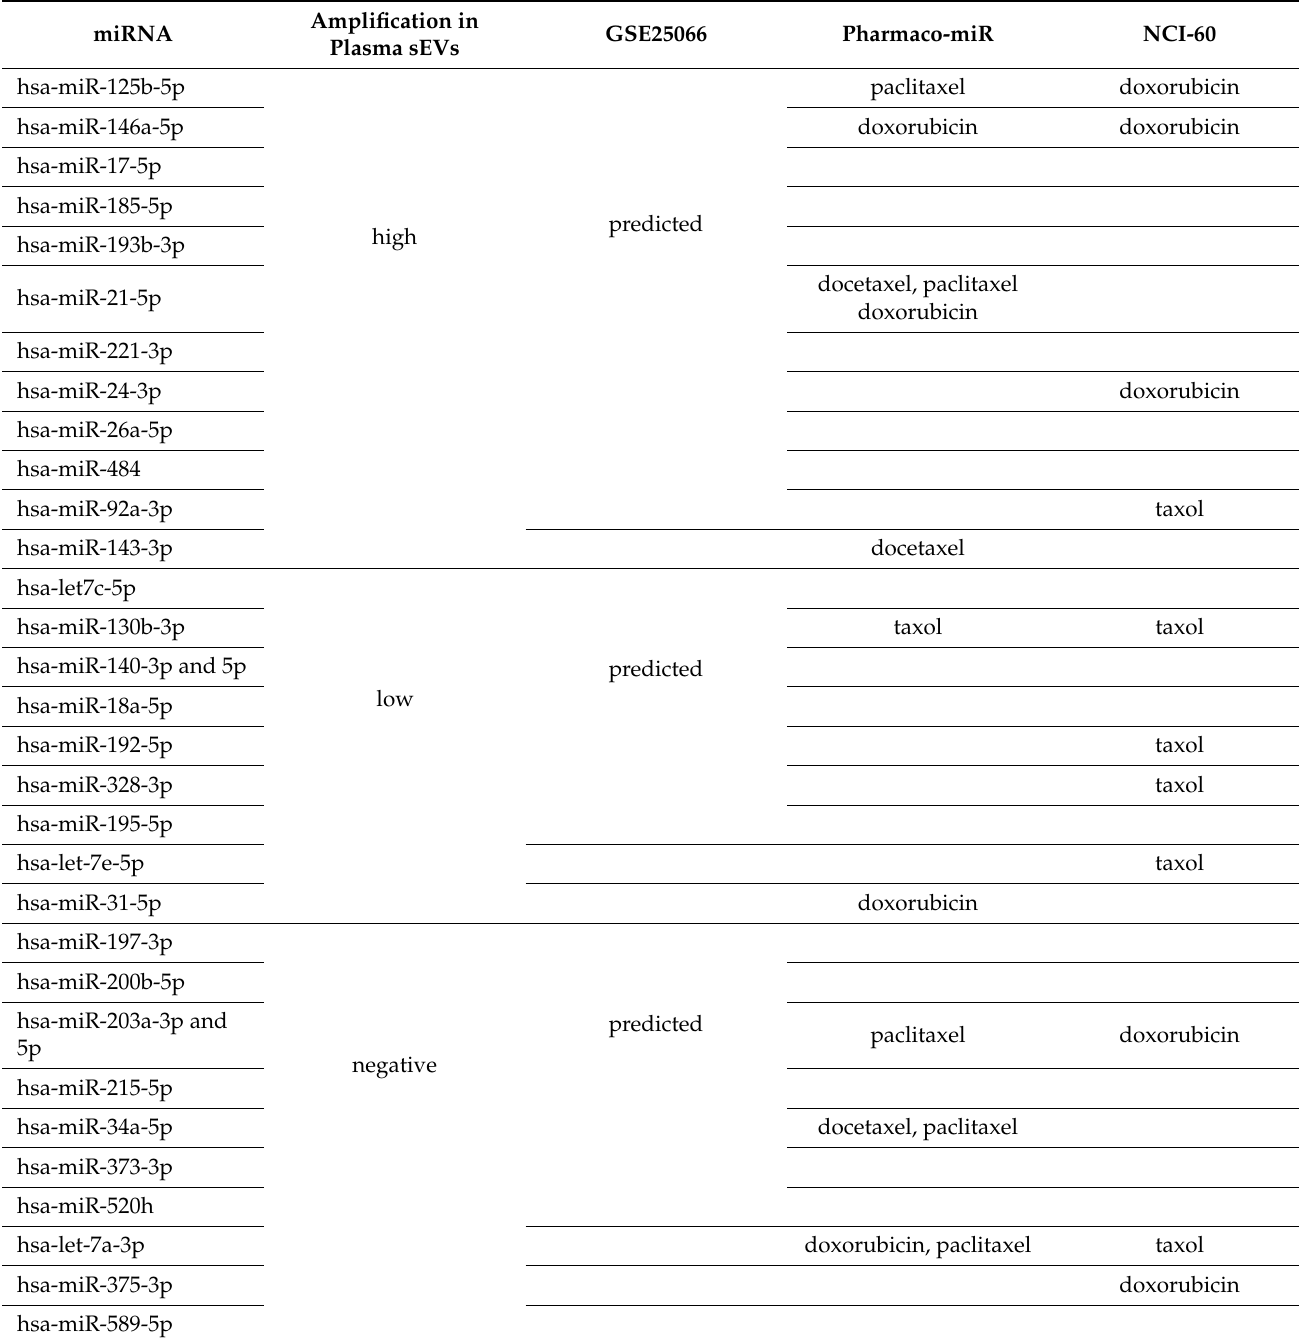
Table 2. Candidate biomarker miRNAs selection and evaluation in plasma